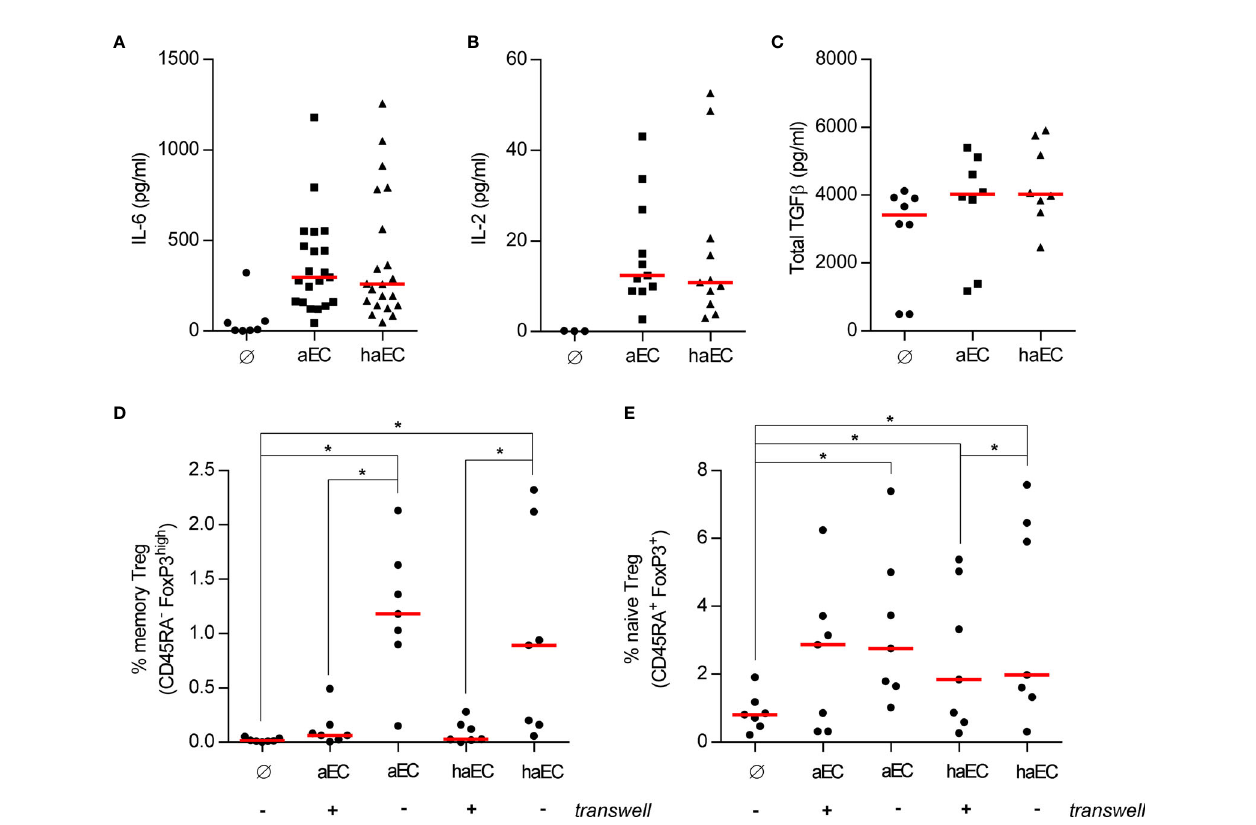
FIGURE 3 | Soluble factors are important for the increased proportion of naïve Treg and not the cause of impaired endothelial-mediated Treg expansion. PBMC were cultured in the absence of endothelial cells (Ø), in the presence of activated endothelial cells (aEC) or highly activated endothelial cells (haEC). After 3 days, the culture supernatants were collected and analysed for the presence of the selected cytokines (medians; Wilcoxon test): IL-6 [ (A) ; n = 21], IL-2 [ (B) ; n = 11] and total TGF b [ (C) ; n = 8]. The physical interaction between endothelial cells and PBMC was prevented by a porous cell culture insert (+ or -) and the expansion of memory [ (D) ; n = 7] or naïve Treg [ (E) ; n = 7] was assessed after 7 days (red lines represent the median; Wilcoxon